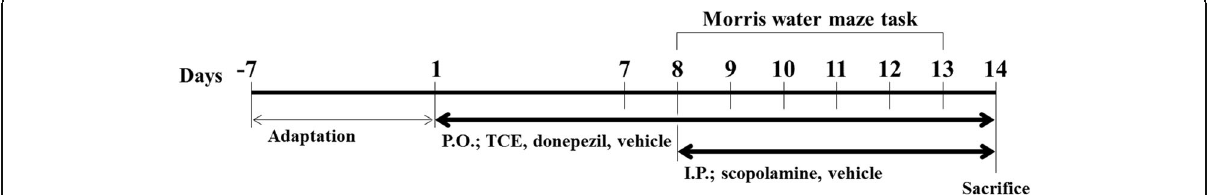
Fig. 1 Schematic description of the experimental design. After a 1-week adaptation, C57BL/6 N mice were orally treated with vehicle (saline), TCE (100 or 200 mg/kg), or donepezil (5 mg/kg) for 14 days. From day 8, the mice were also treated intraperitoneally with vehicle (saline) or scopolamine (1 mg/kg) for 7 days. The Morris water maze was conducted on days 8 – 13 to evaluate memory function. All mice were sacrificed on day 14. The hippocampus was then collected for further biochemical analyses. P.O.; per os (by mouth, orally), I.P.;